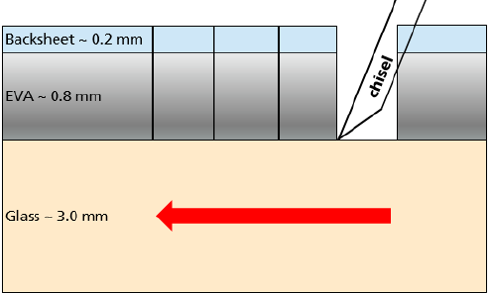
Figure 7. Schematic depiction of the investigated laminate during the sample preparation for nanoindentation and shear tests at